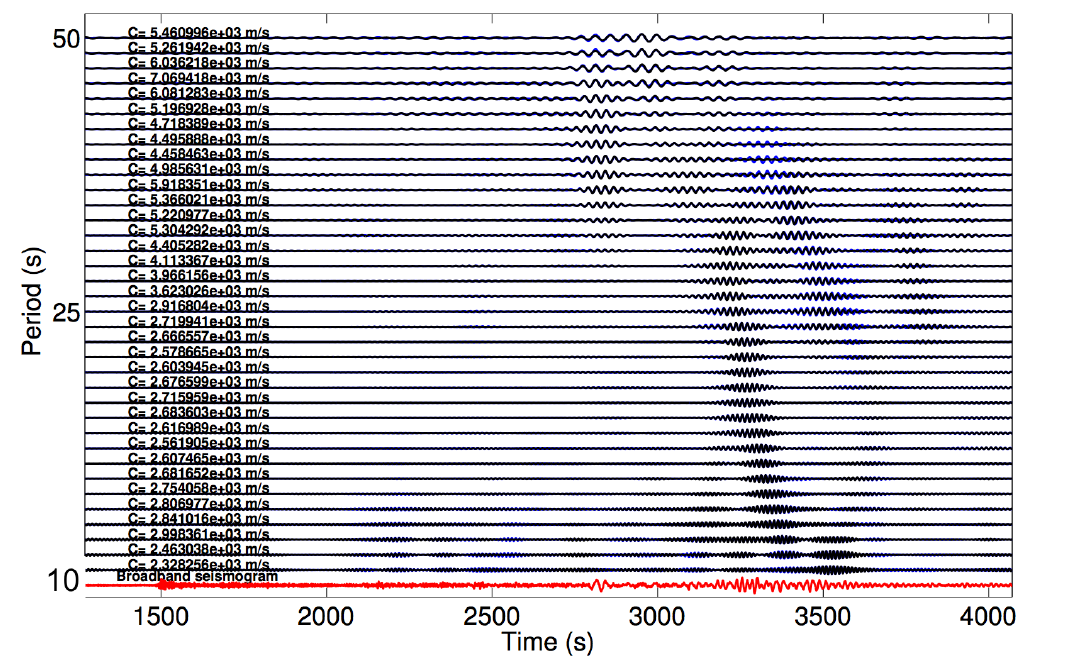
Figure 6: Superposition of transverse acceleration (black) and rotation rate (blue) and determination of phase velocities as a function of dominant period after narrow-band filtering. Each trace has been individually normalised. Phase velocities reported at the left side of the plot are obtained from the amplitude ratio of the envelope’s maxima (see text for